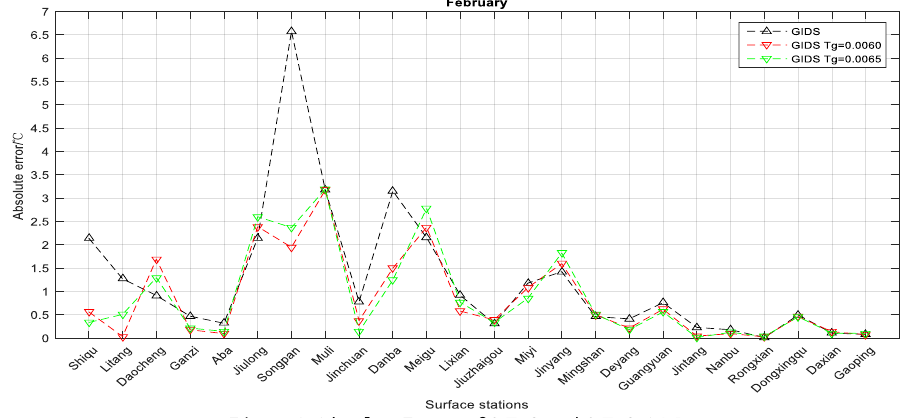
Figure 4. Absolute Errors of GIDS and